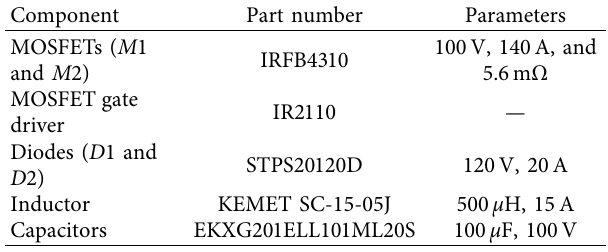
Table 2: Component list of the TLBC circuit.